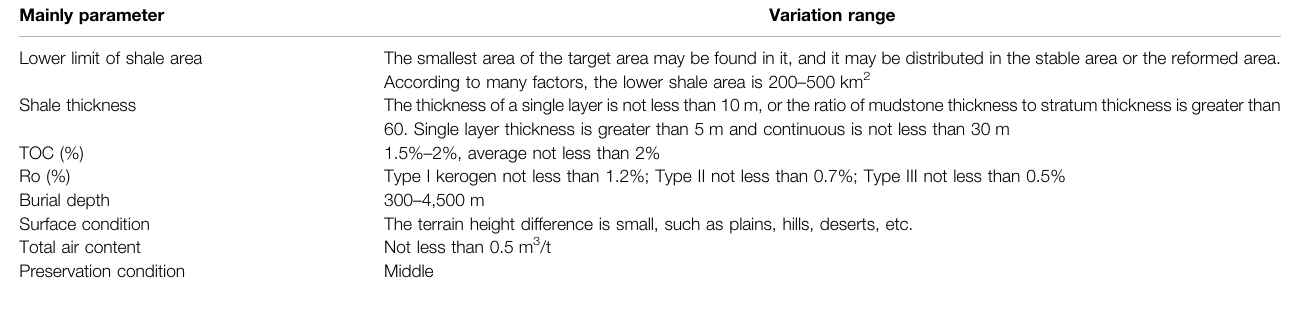
TABLE 2 | Reference standard for optimization of favorable areas of continental and transitional shale gas. Mainly parameter Lower limit of shale